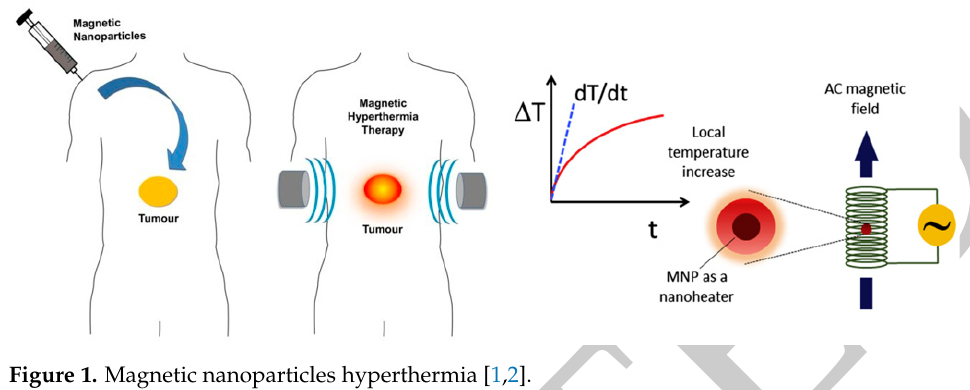
Figure 1. Magnetic nanoparticles hyperthermia. [1,2].